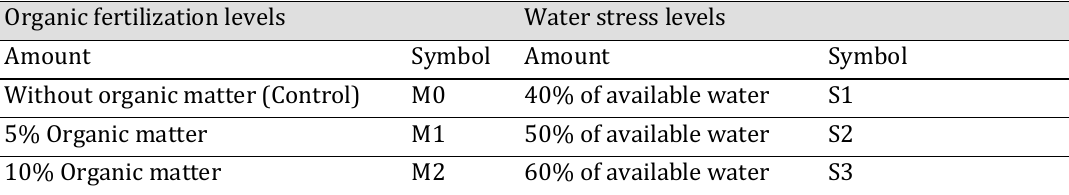
Table 3. Experiment levels in regards to the adde d organic matter a nd the applie d water stress